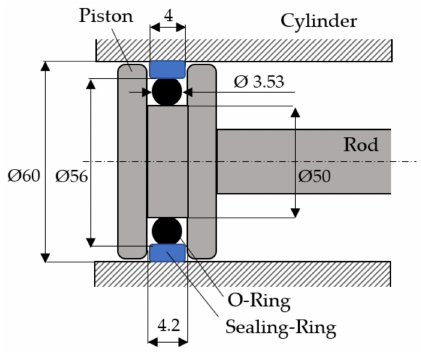
Figure 2. Essential dimensions of sealing